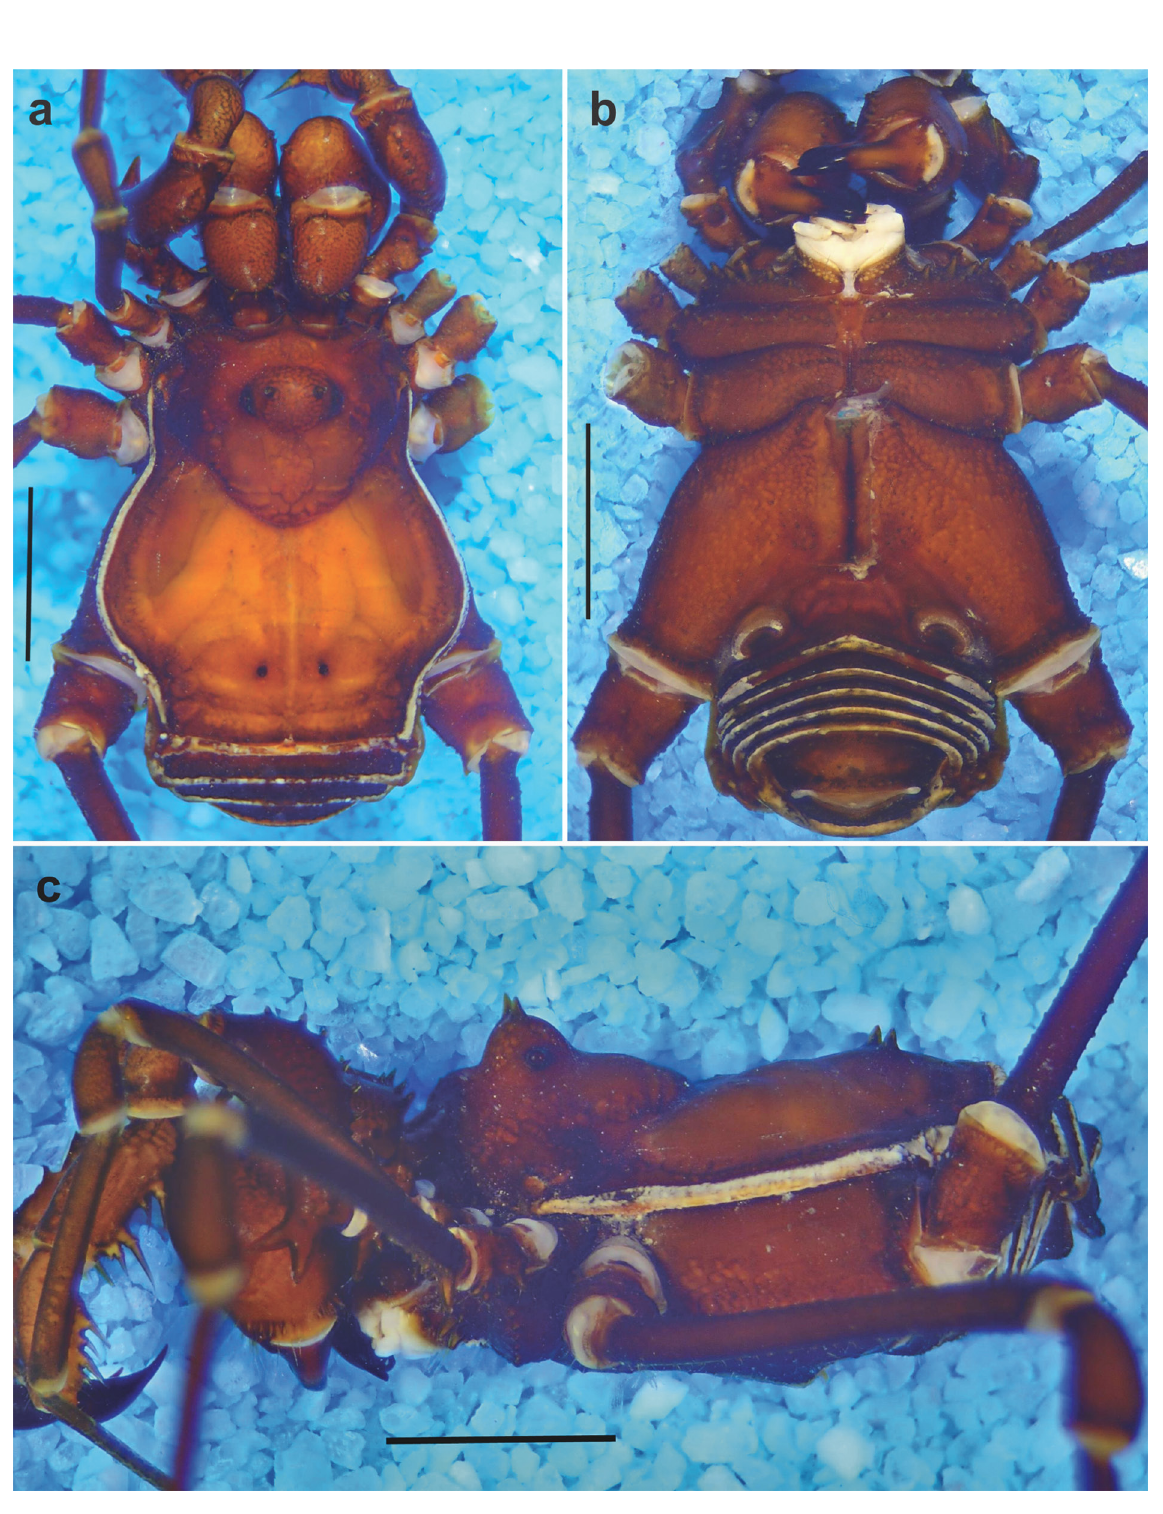
Fig. 4. Phalangodus briareos sp. nov., ♂, holotype (MNRJ 2382). a . Habitus, dorsal view. b . Habitus, ventral view. c . Habitus, lateral view. Scale bars = 5